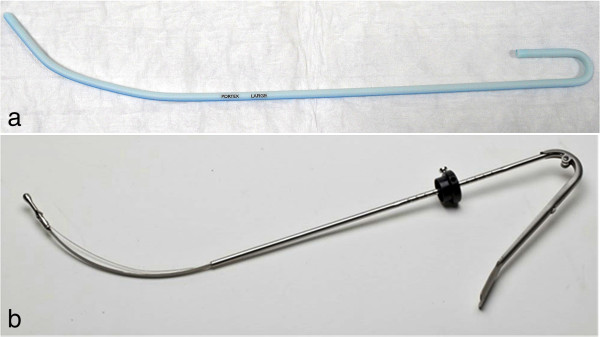
Stylets used in the intervention arms. (a) Conventional Portex™ intubation stylet used in group A patients. (b) Truflex™ articulating stylet with stopper used in group B patients.